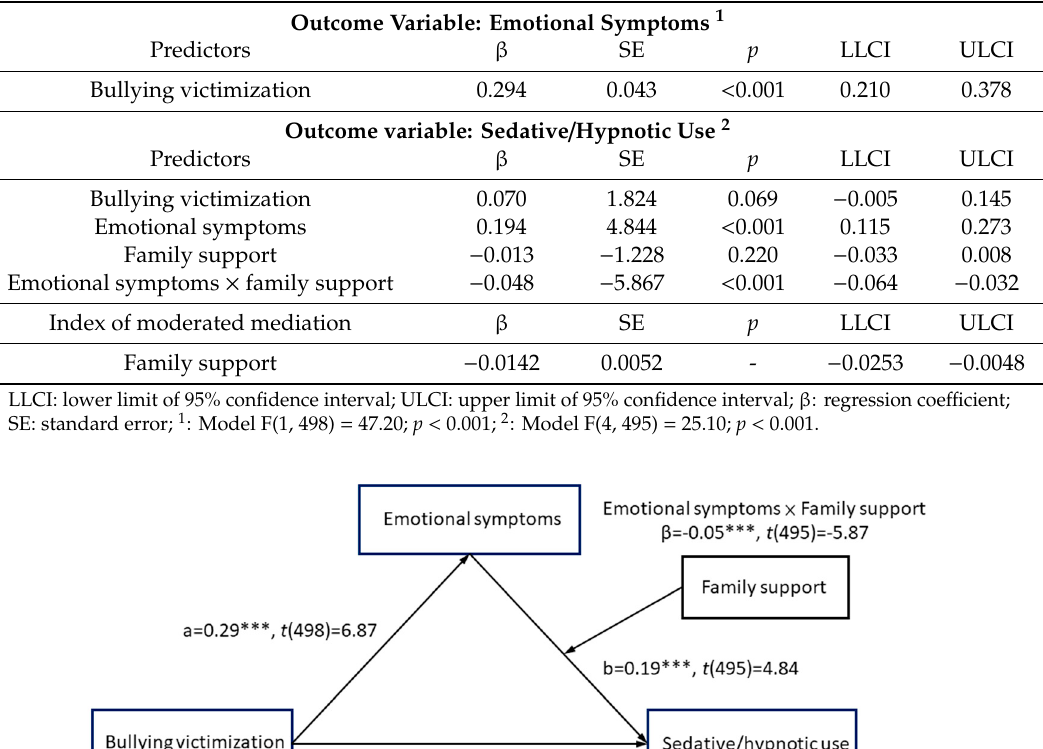
Table 3. Ordinary least squares regression results for moderated indirect e ff ect.